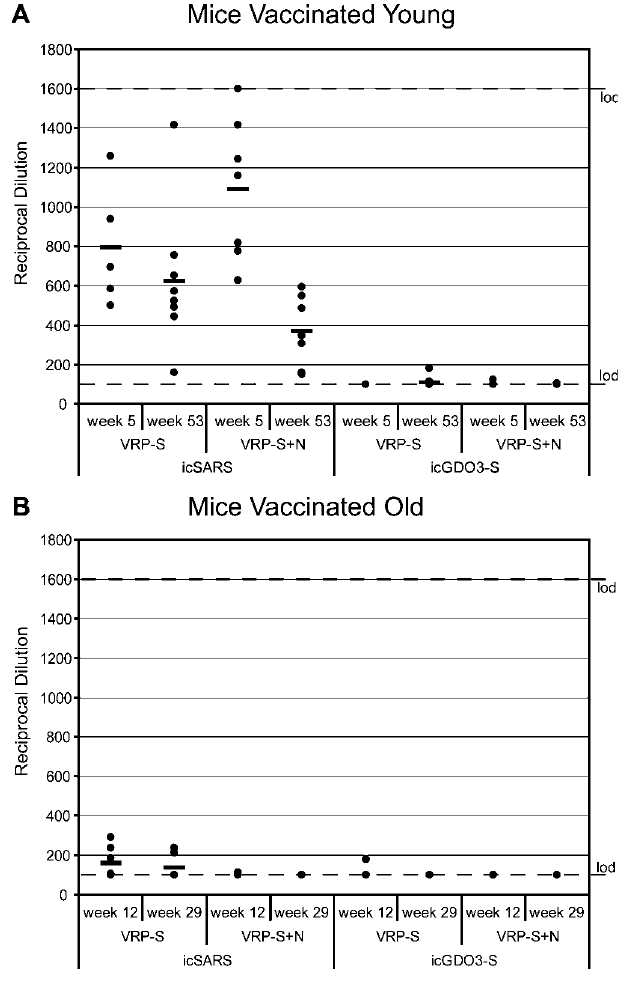
Figure 5. An 80% Plaque Reduction Neutralization Titers (PRNT 80 ) for VRP-S and VRP-S þ N Hyperimmune Serum (A) Mice vaccinated young: icSARS-CoV (left) and icGDO3-S (right) PRNT 80 for VRP-S immune serum (experiment 2) collected at 5 wk post-boost ( n ¼ 5) and 53 wk post-boost ( n ¼ 8). (B) Mice vaccinated old: icSARS (left) and icGDO3-S (right) PRNT 80 values for VRP-S and VRP-S þ N immune serum (experiment 4) at 12 and 29 wk post-boost ( n ¼ 6 for icSARS; n ¼ 5 for icGDO3-S). The PRNT 80 values for individual animals are show as black circles, and the mean value is shown as a solid bar. The limits of detection (1:1,600 upper and 1:100 lower) are represented by horizontal dotted lines.